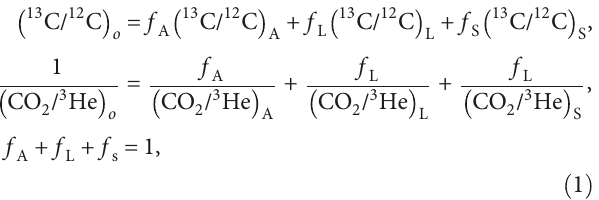
Figure 5: Probability plots of soil gas Rn activities in the 388 sampling